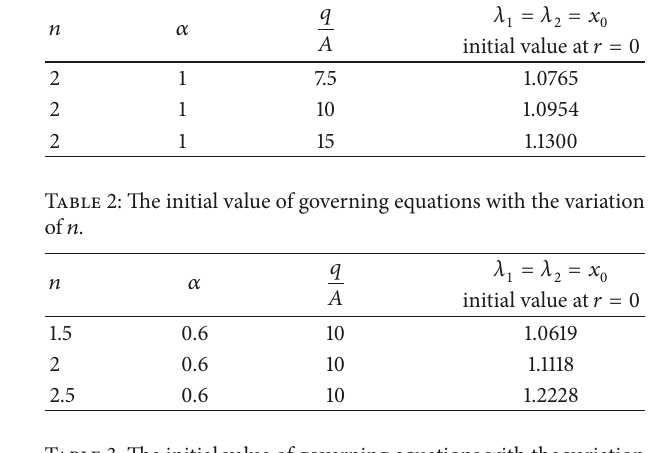
Table 3: The initial value of governing equations with the variation of 𝛼